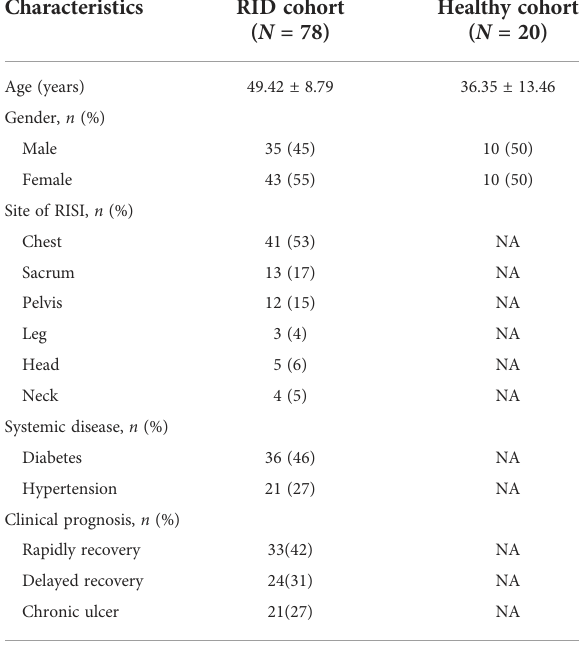
TABLE 1 Clinicopathological characteristics of patients with radiation-induced dermatitis (RID).